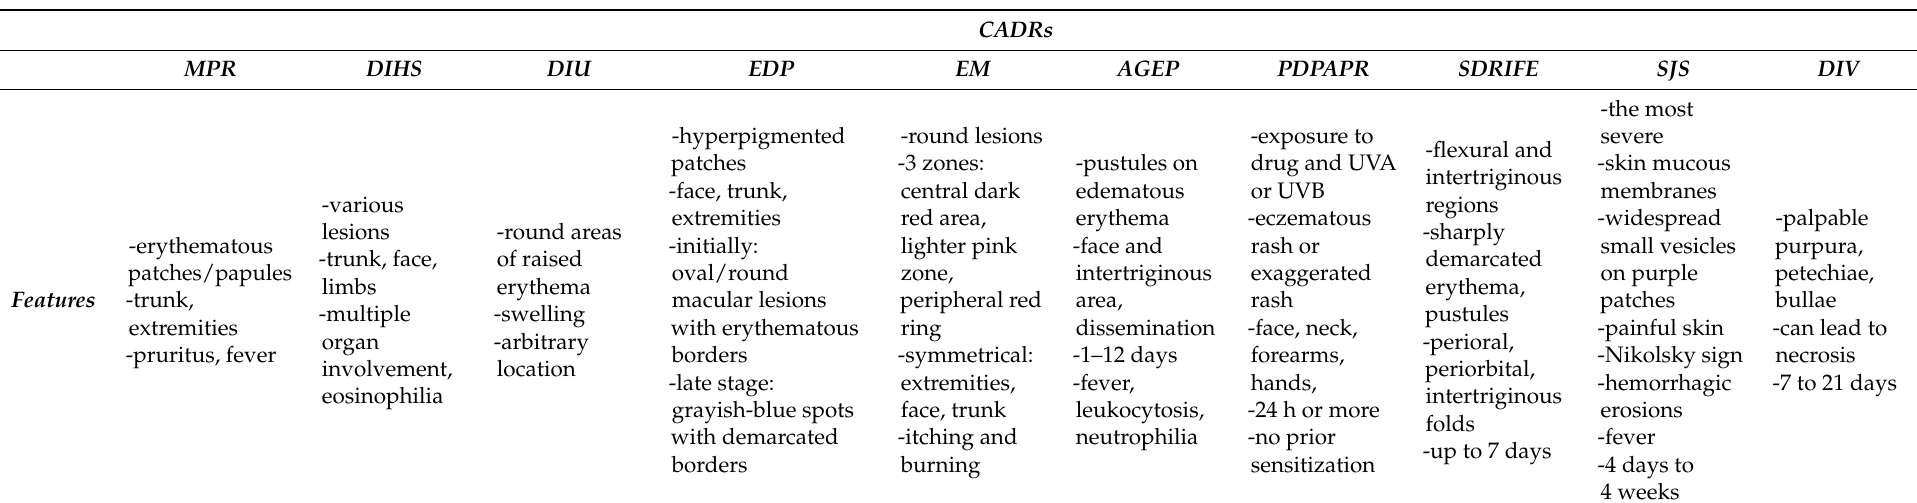
Table 1. Characteristics of